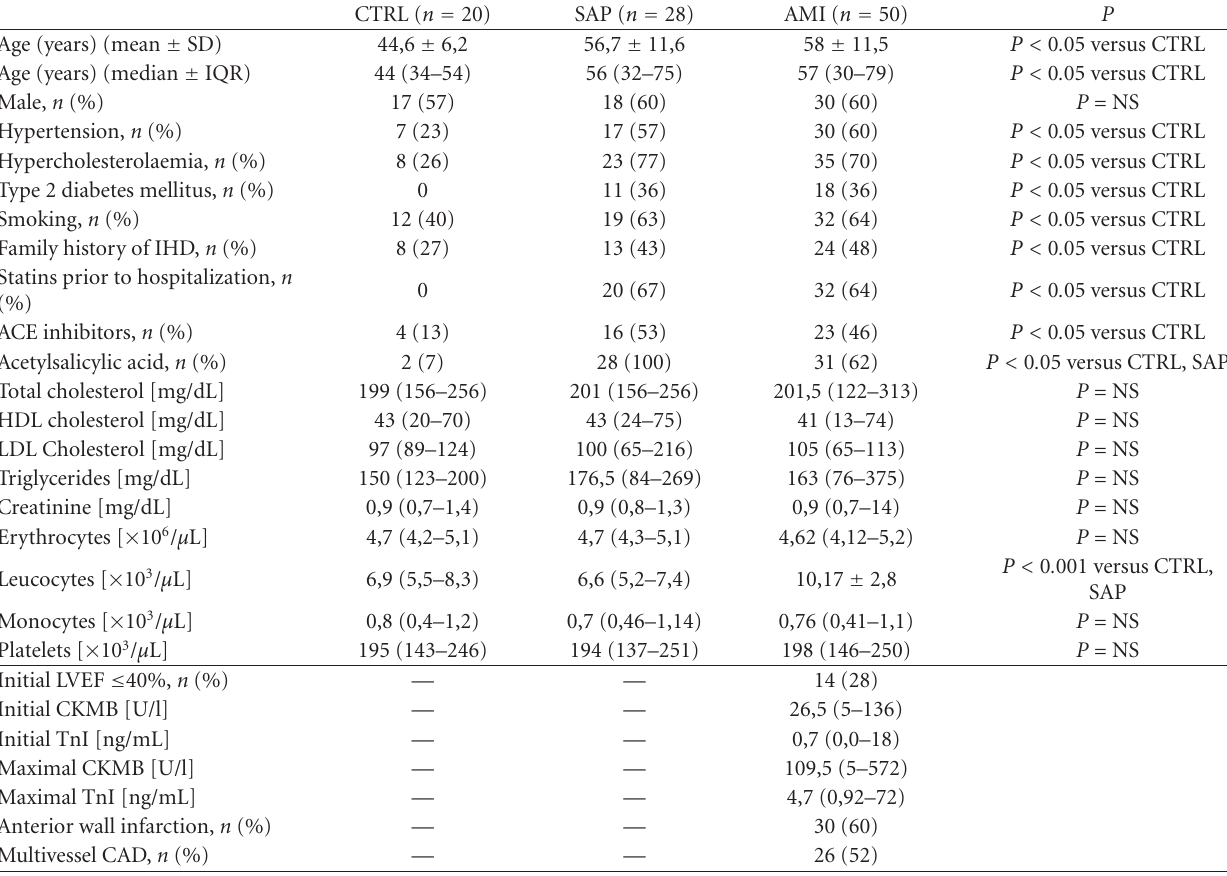
Table 1: Characteristics of the study